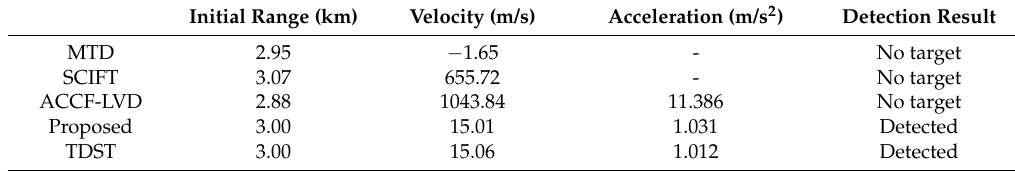
Figure 7. Integration performance comparison. ( a ) Parameter estimation result of LVD; ( b ) integration result of the ACCF-LVD; ( c ) parameter estimation result of the proposed algorithm; ( d ) integration result of the proposed algorithm; ( e ) parameter estimation result of the TDST; ( f ) integration result of the TDST. Table 3. Comparisons of simulated parameter estimation and target detection results.